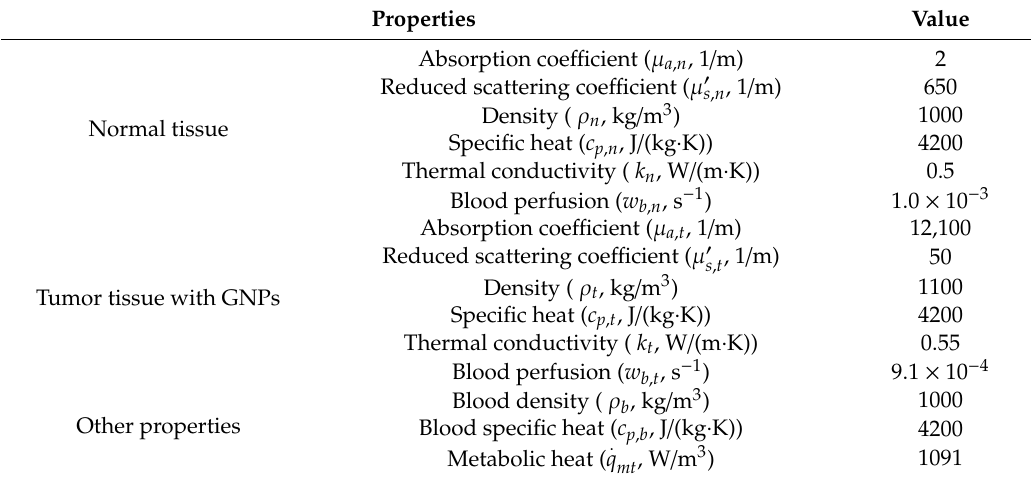
Table 2. Properties for verification of the numerical analysis.